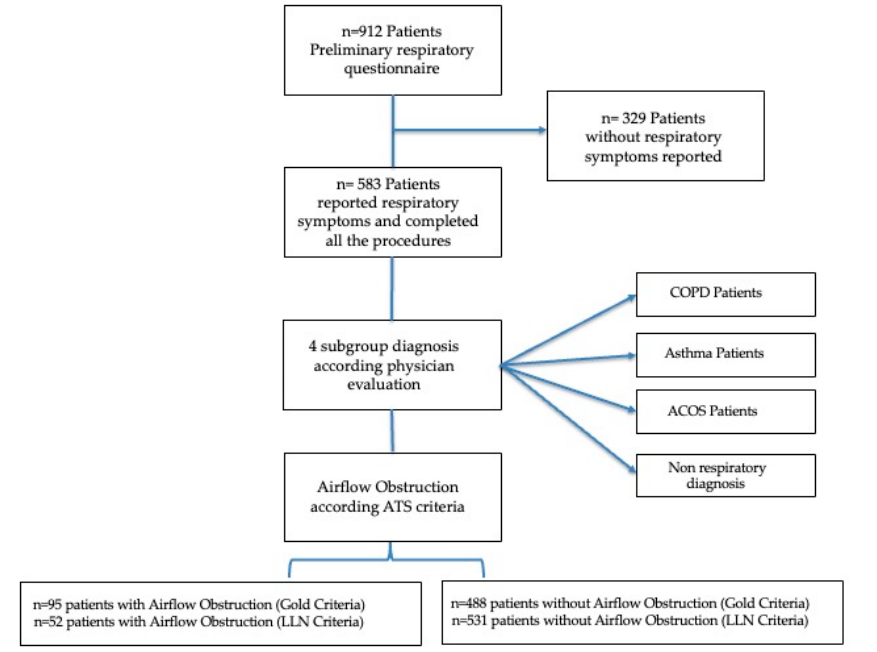
Figure 1. Patient flow diagram.